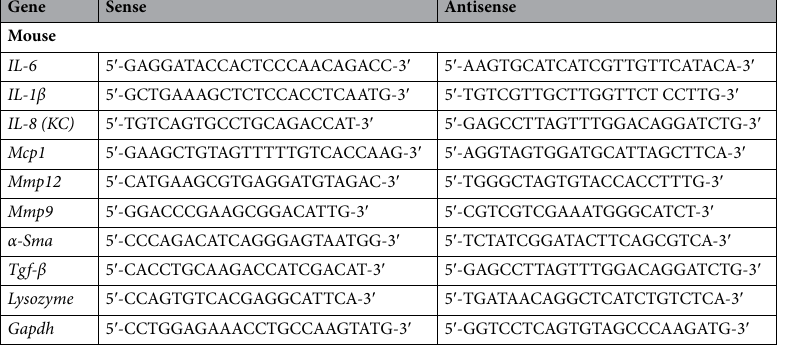
Table 2. Primers used in